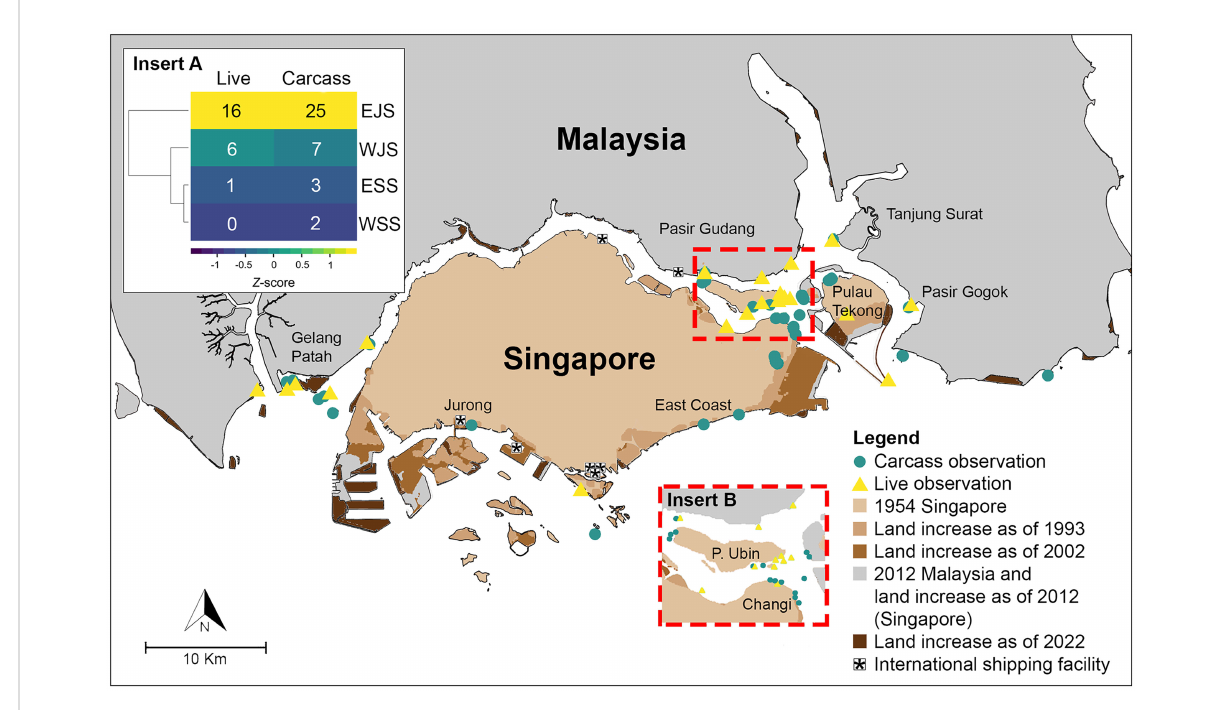
FIGURE 2 Distribution of live and carcass observations in Singapore between 1954 and 2020. Insert shows the section of the eastern Johor Strait where the most dugong observations were recorded. Records which were not accompanied with location information are not represented in this fi gure. Insert A : Hotspots of dugong observations revealed through Euclidean-based hierarchical distance clustering. EJS, WJS, ESS and WSS refers to the eastern and western Johor Strait and the eastern and western Singapore Strait respectively. Numbers depict the counts per observation in each broad